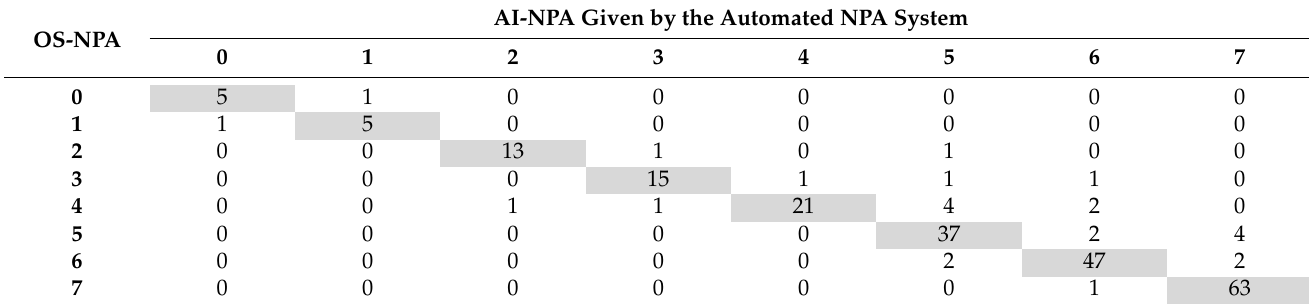
Table 2. Confusion matrix of the NIPS pain scores for OS-NPA and AI-NPA.